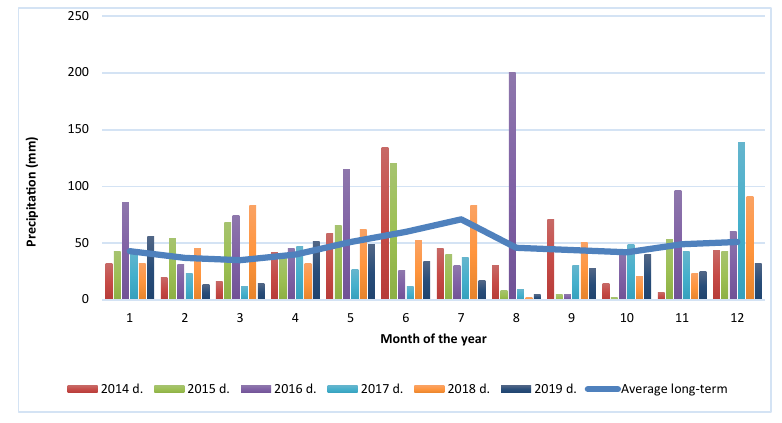
Figure 1 Average monthly precipitation during 2014–2019.